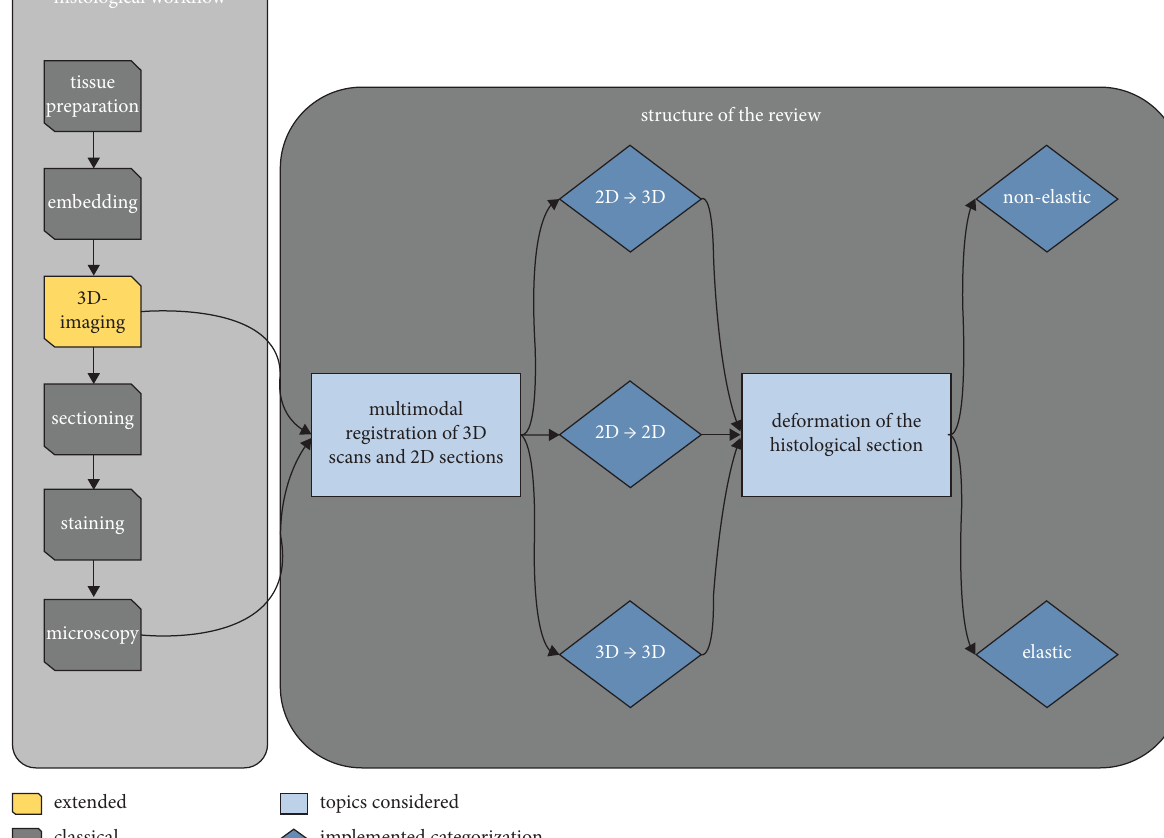
Figure 1: An overview of the presented review concerning multimodal registration of 3D scans and 2D sections. Te methods described here extend the classical histological workfow with 3D imaging before sectioning. Tus, image representations of the tissue are present in two modalities. Te research considered is grouped according to the dimensionality of the addressed problem into slice-to-volume (2D ⟶ 3D), slice-to-slice (2D ⟶ 2D), and volume-to-volume (3D ⟶ 3D) registration. Each category is further subdivided into elastic and non-elastic algorithms. Tis results in a specialized selection of algorithms that match and remedy the corresponding severity of deformations introduced during the sectioning